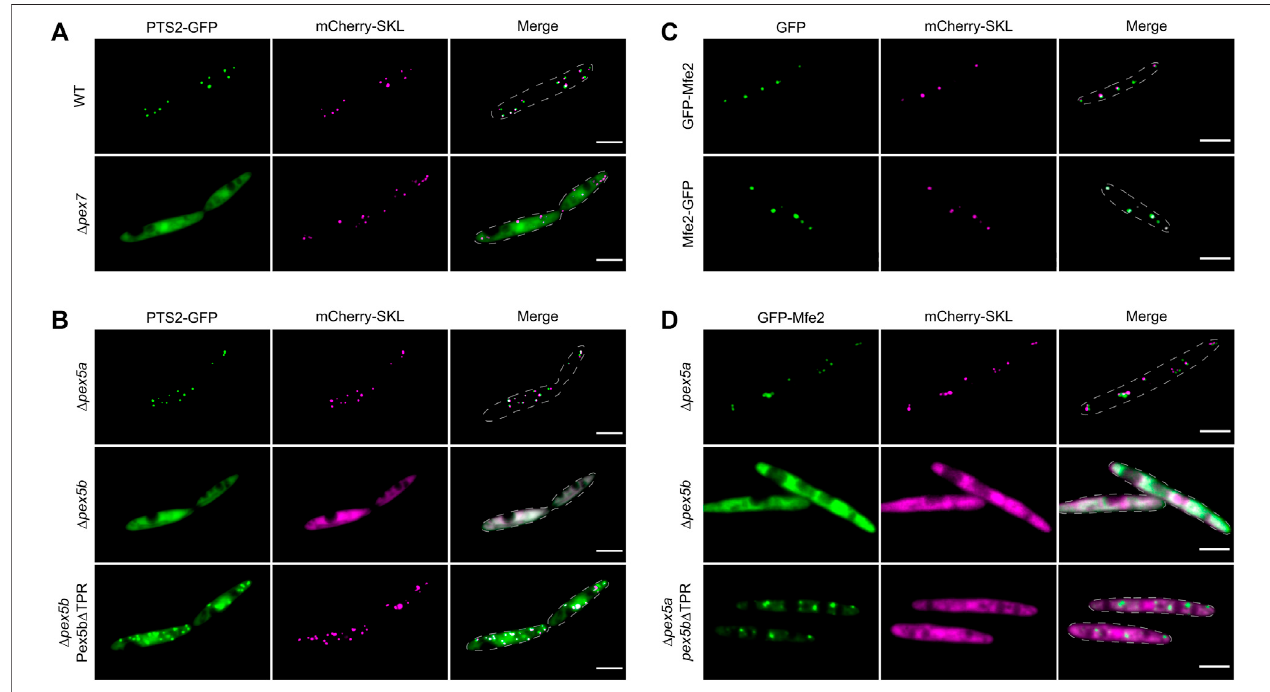
FIGURE6| TheNTDofPex5bisacrucialfactor formatrixprotein import in U.maydis .Fluorescence microscopic images ofindicatedstrainsexpressing mCherry- SKL(magenta) togetherwithPTS2-GFP(green) (A , B) or withGFP-tagged Mfe2(green) (C , D) .Thedatashow thattheNTDofPex5b isinvolved inperoxisomal targeting of PTS2 proteins and more unusual cargo such as the multifunctional enzymes (Mfe2). Scale bars represent 5 µm.